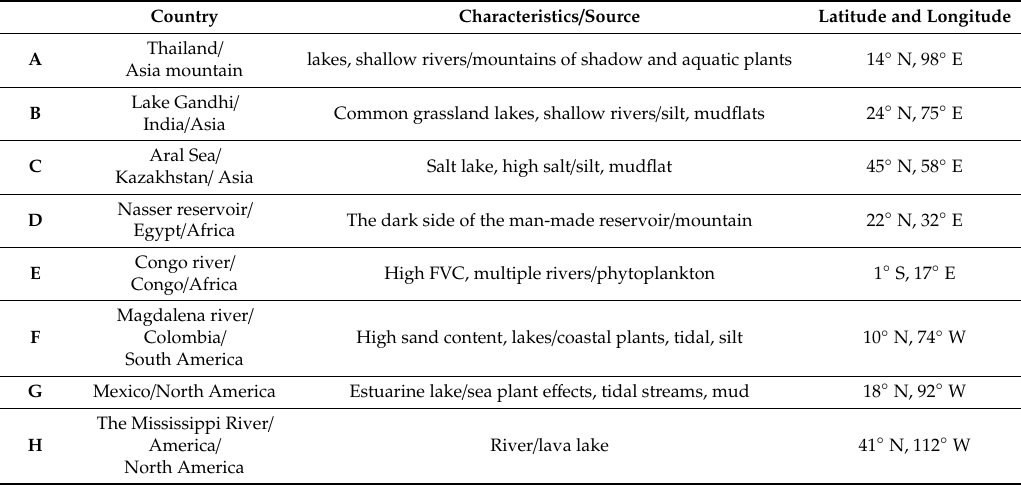
Table 2. Test point characteristics and their latitude and